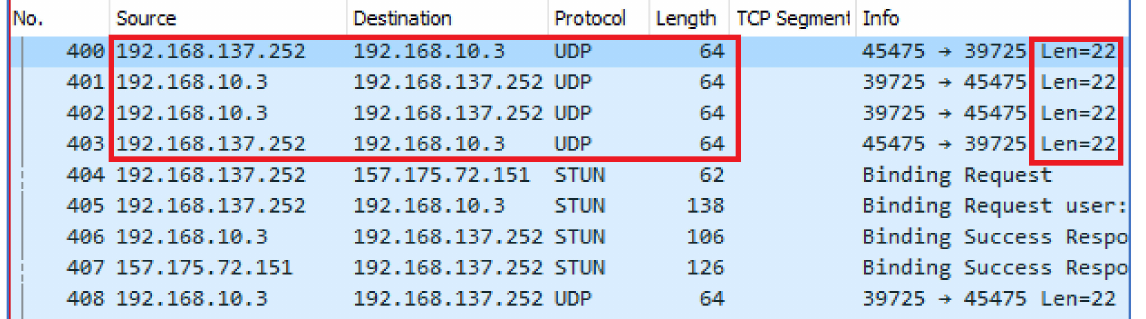
Figure 14. The flow of UDP packets during a call.